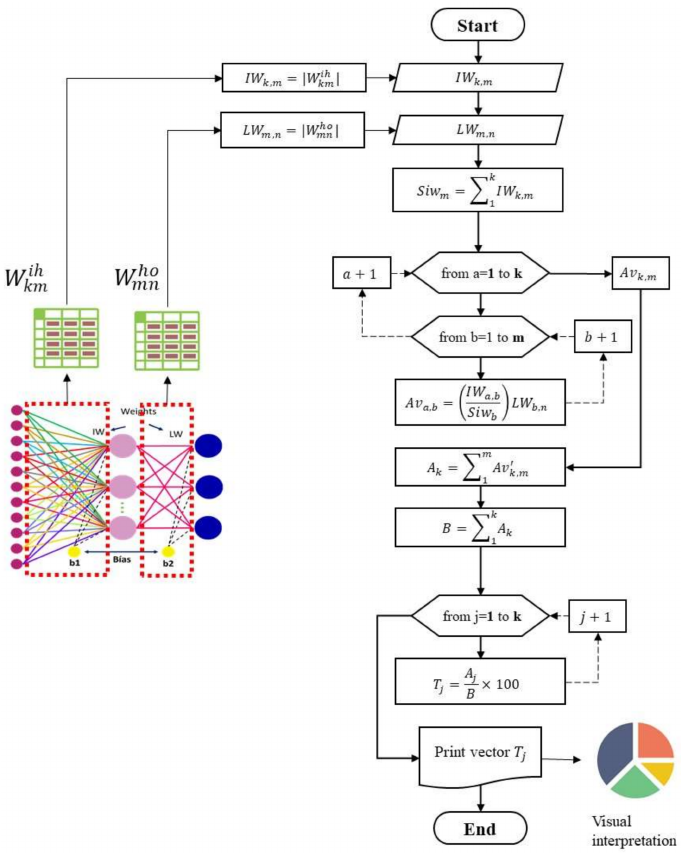
Figure A1. Numerical procedure for the implementation of Garson’s method as a sensitivity analysis